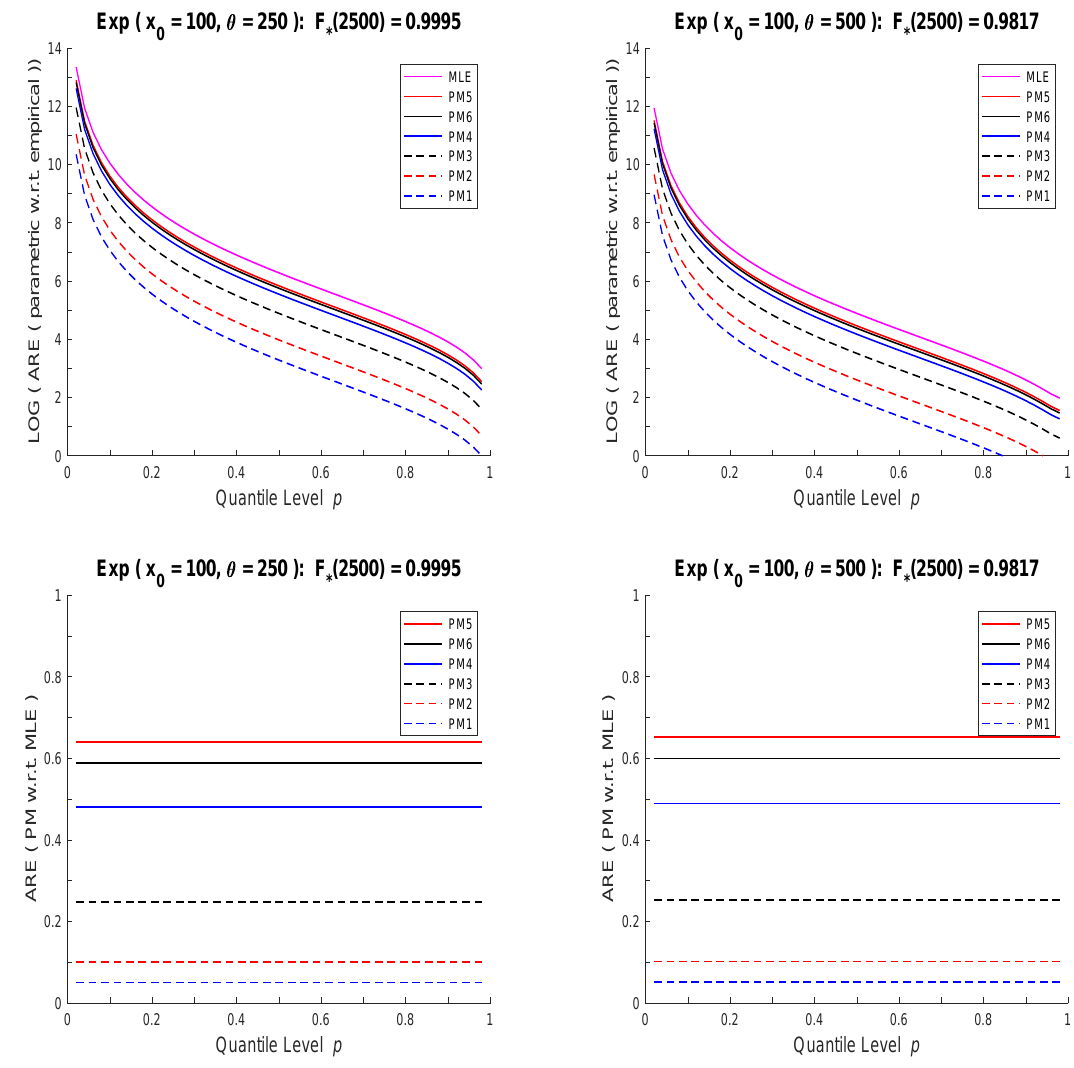
Figure 1. Relative efficiency curves (RECs) of quantile estimators of the exponential ( x 0 = 100, θ ) Figure 3.1. RECs of quantile estimators of the exponential( x 0 = 100 , θ ) distribution distribution for t = 500, u = 2500, n = 100, and θ = 250 ( left column ), θ = 500 ( right column ). Level p 1 = 0.05 ( PM 1 ), 0.10 ( PM 2 ), 0.25 ( PM 3 ), 0.50 ( PM 4 ), 0.75 ( PM 5 ), 0.90 ( PM 6 ). Top row : Plots of formulas for t = 500, u = 2500, n = 100, and θ = 250 (left column), θ = 500 (right column). (11) and (12). Bottom row : Plots of formula Level p 1 = 0.05 ( pm 1 ), 0.10 ( pm 2 ), 0.25 ( pm 3 ), 0.50 ( pm 4 ), 0.75 ( pm 5 ), 0.90 ( pm 6 ). Top row : Plots of formulas (3.4) and (3.5). Bottom row : Plots of formula (3.6).